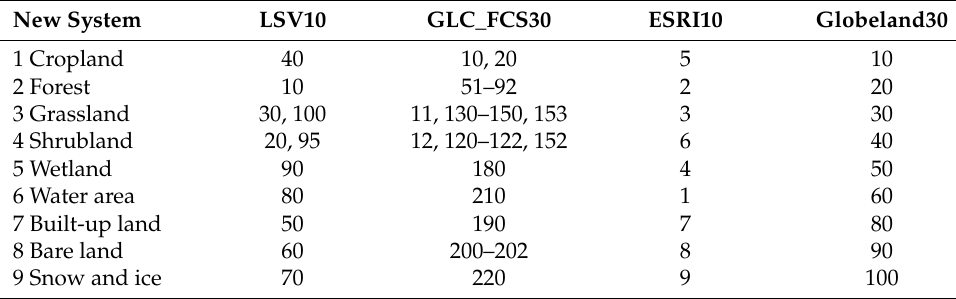
Table 3. Correspondence between old and new LULC